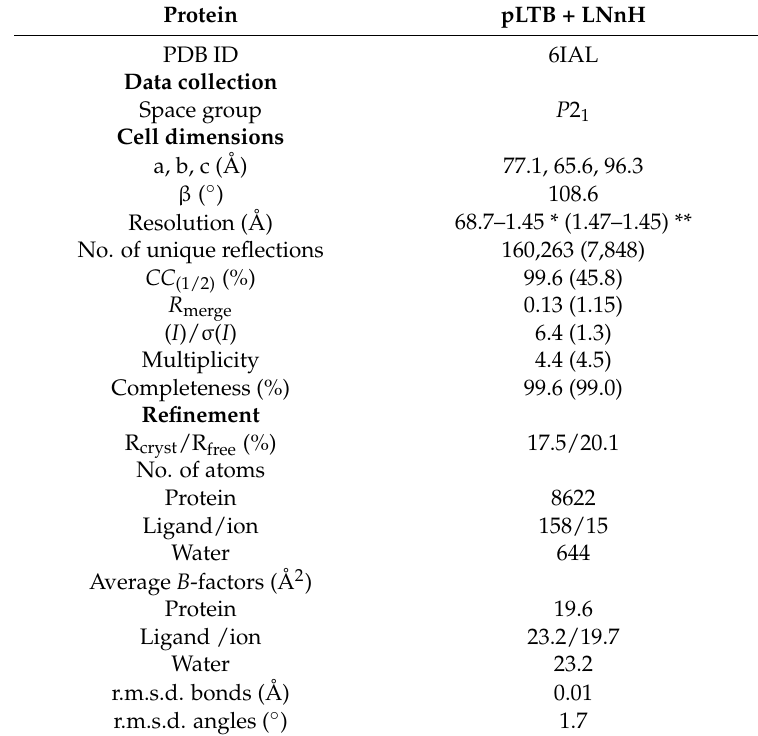
Table 3. Data collection and refinement statistics